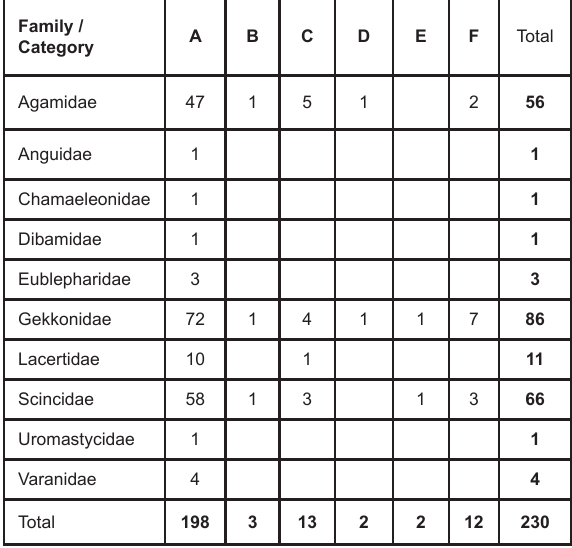
Table 2. Updated Family wise categorization of Indian lizard species based on distributional